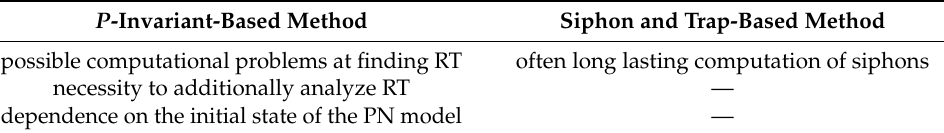
Table 2. Disadvantageous of both